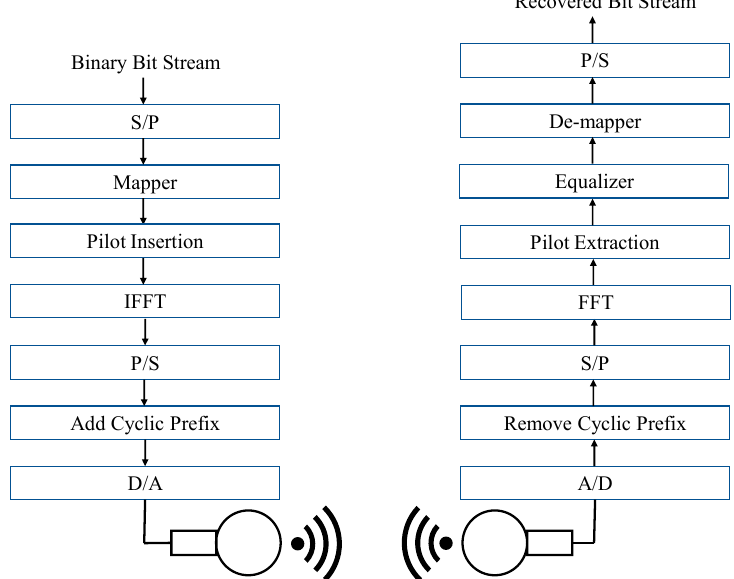
Figure 1. A typical CP-OFDM transceiver with a channel estimation using pilots.